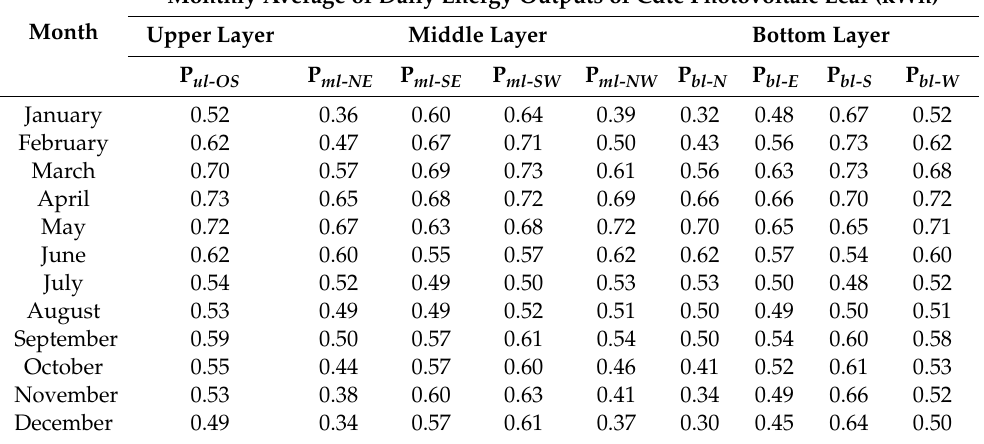
Table 7. Monthly average of daily energy outputs of CdTe photovoltaic leaves in the three di ff erent layers of the solar photovoltaic tree. Monthly Average of Daily Energy Outputs of Cdte Photovoltaic Leaf (kWh) Month Upper Layer Middle Layer Bottom Layer P ul-OS P ml-NE P ml-SE P ml-SW P ml-NW P bl-N P bl-E P bl-S P